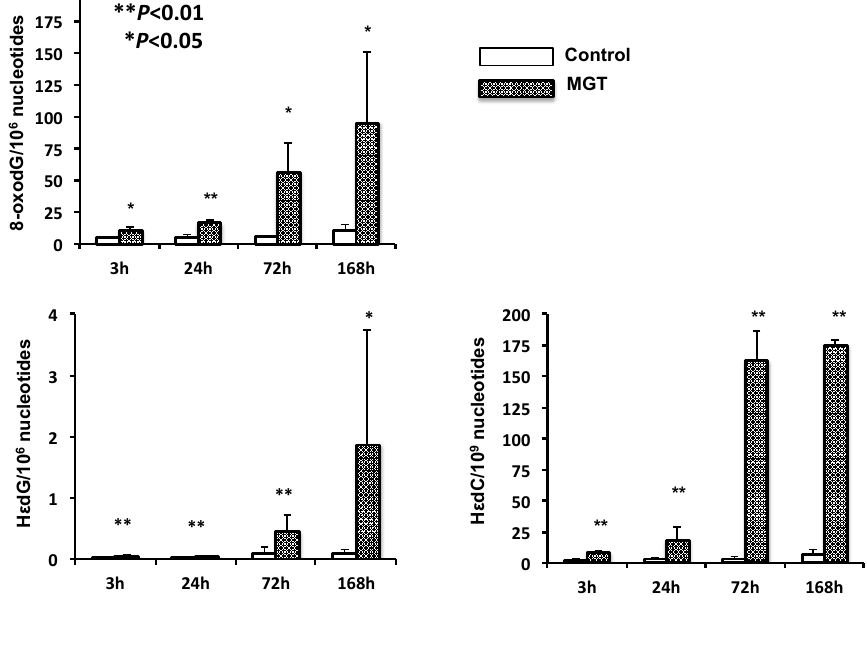
Figure 5. Oxidative and lipid peroxide-related DNA adduct formation induced by MGT exposure in the lungs of ICR mice. DNA was extracted from the lungs 3, 24, 72 and 168 h after intratracheal instillation of 0.2 mg of MGT, and was digested enzymatically. Control samples were obtained from the lungs of mice given the vehicle for the same durations of MGT exposure. 8-Oxo-7,8-dihydro-2 ′ -deoxyguanosine (8-oxodG) and two types of H ε -adduct were quantified by stable isotope dilution liquid chromatography-mass spectrometry (LC-MS/MS). Asterisks (* and **) indicate a significant difference ( P < 0.05 and P < 0.01) from vehicle control (treatment with 0.05% ( v / v ) Tween-80) at the same point in the Student’s t